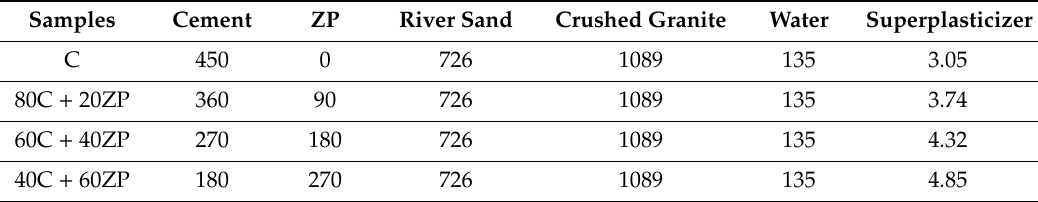
Table 2. Mix proportions of concretes (kg / m 3 ).